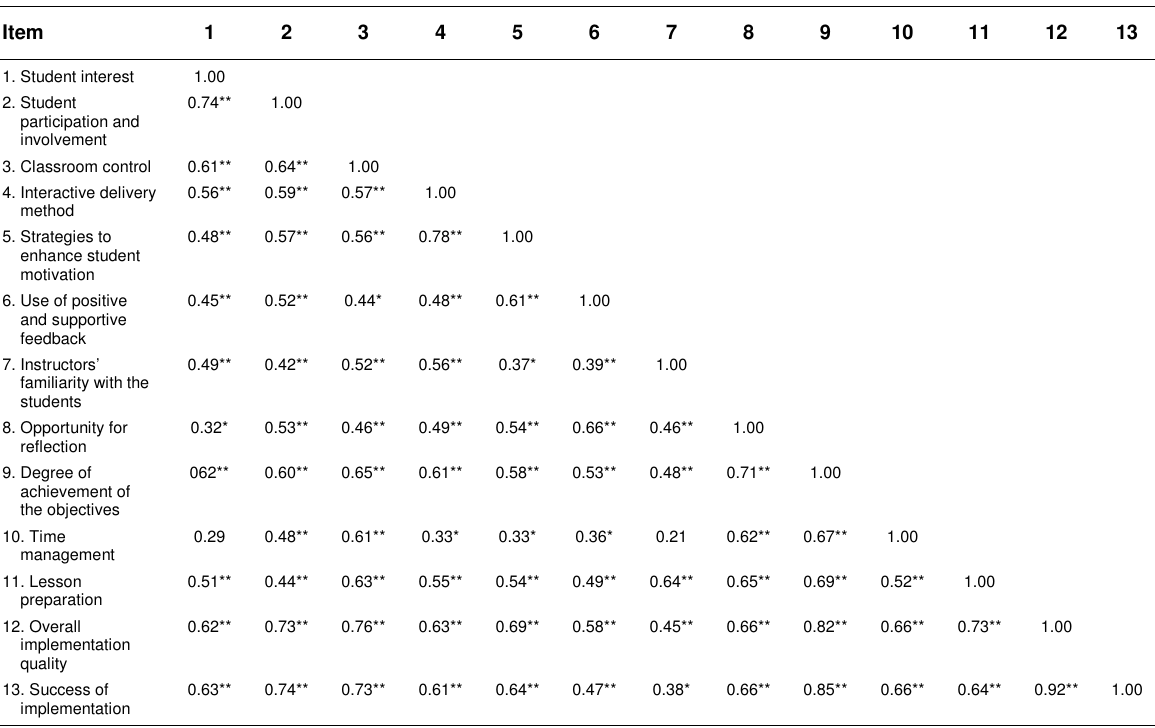
Intercorrelations among Items of the Curriculum Delivery